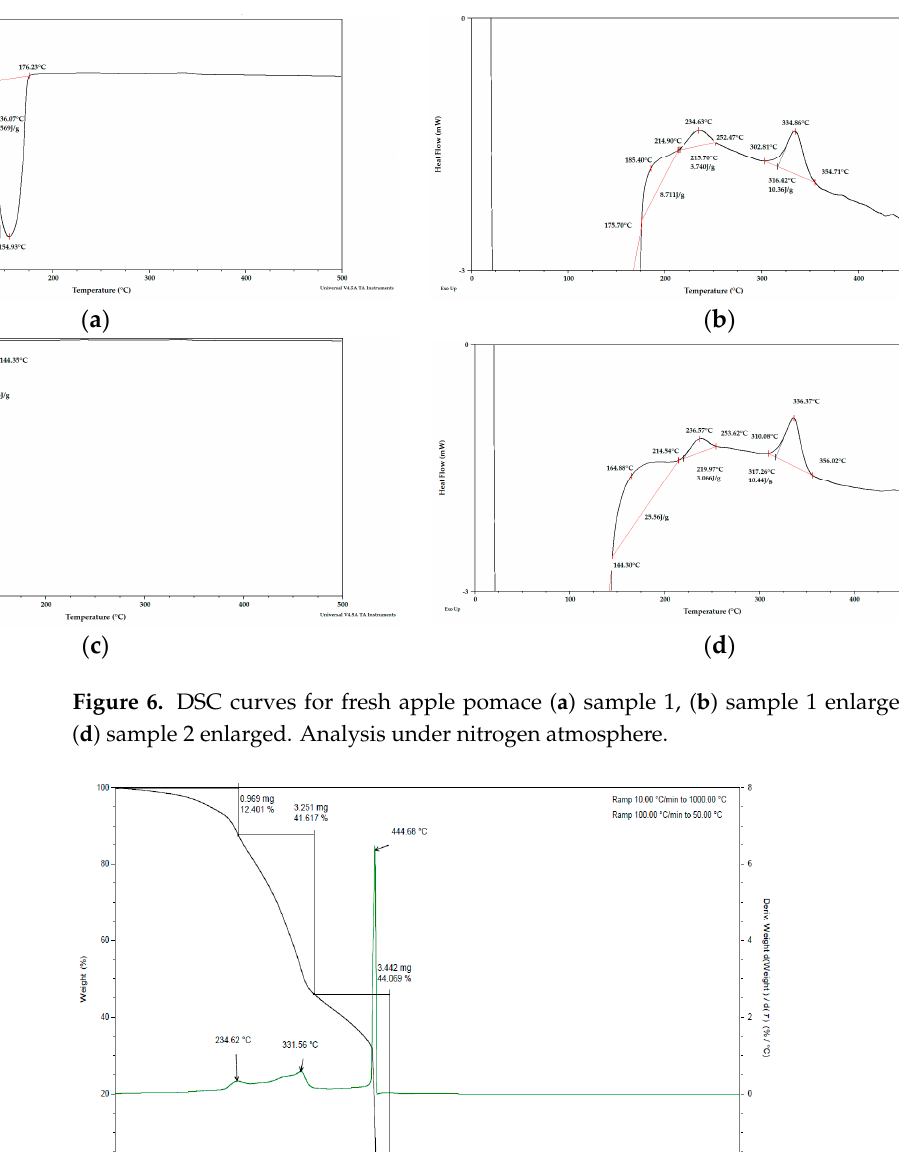
under nitrogen atmosphere.